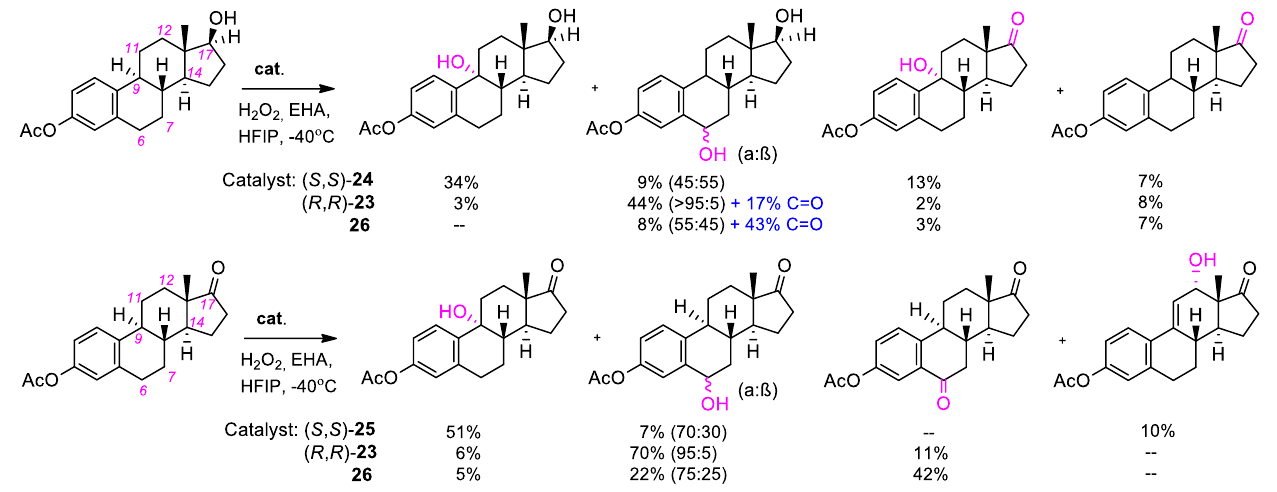
Scheme 13. Examples of selectivity of manganese catalysts depending on absolute chirality and